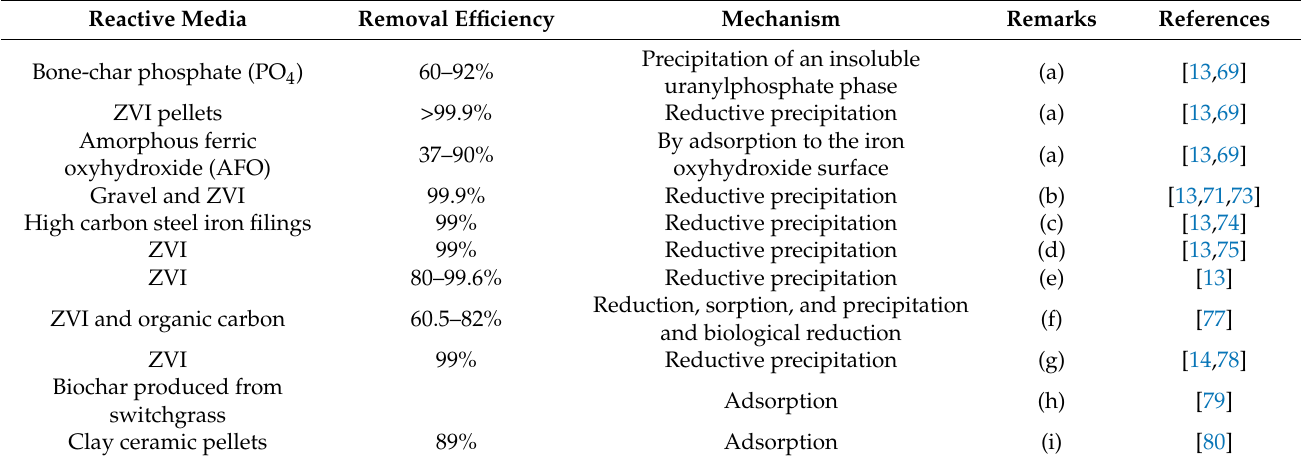
Table 3. Summary of the permeable reactive barrier (PRB) performance for uranium